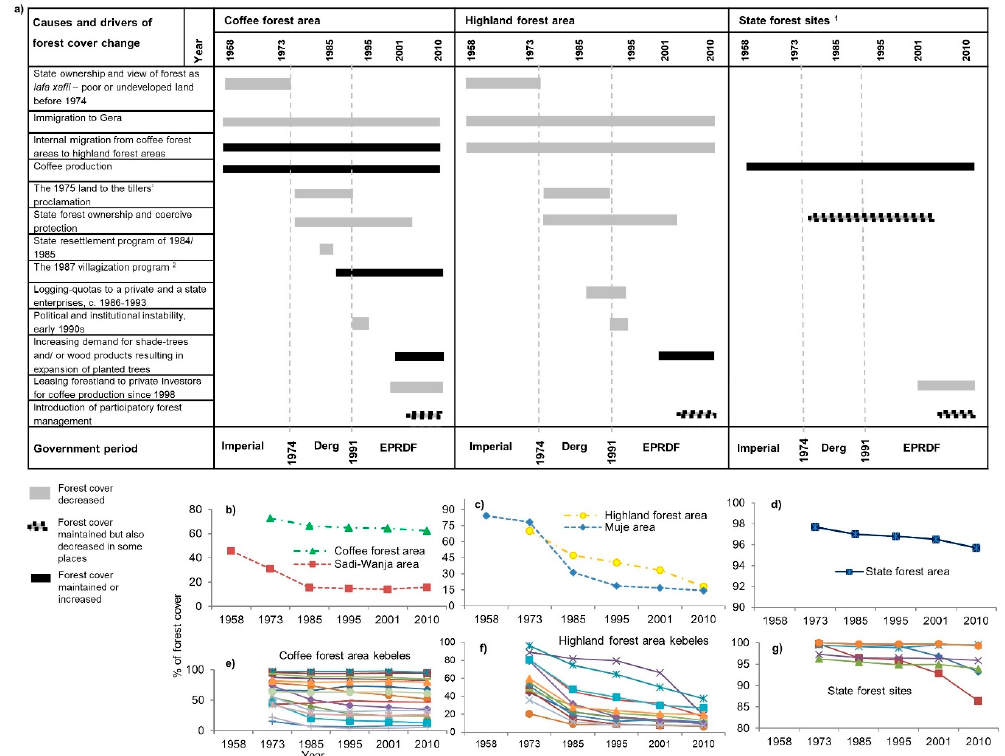
Figure 5. Summary of causes and drivers of forest cover change and percentages of forest cover in coffee and highland forest areas and state forest sites of Gera, 1958–2010 ( a ). Imperial refers to the pre-1974 feudal monarchy; Derg was the socialist military government; and EPRDF stands for Ethiopian People’s Revolutionary Democratic Front, a party that took government power since 1991. The y-values ( b – g ) are percentages of forest cover in 1958, 1973, 1985, 1995, 2001, and 2010. Blank spaces in ( a ) indicate that the driver is not relevant or that data is lacking for that specific land area. 1 Some of the state forest sites include forest and semi-managed forest coffee. 2 In the villagization program, the Derg government forced farmers in and around forests to move to a newly established village far from forest edges. This move led to forest recovery in limited parts of a small number of coffee area kebeles, e.g., Wanja Kersa, since the fields were left uncultivated. Afterwards, the recovered forest was maintained.